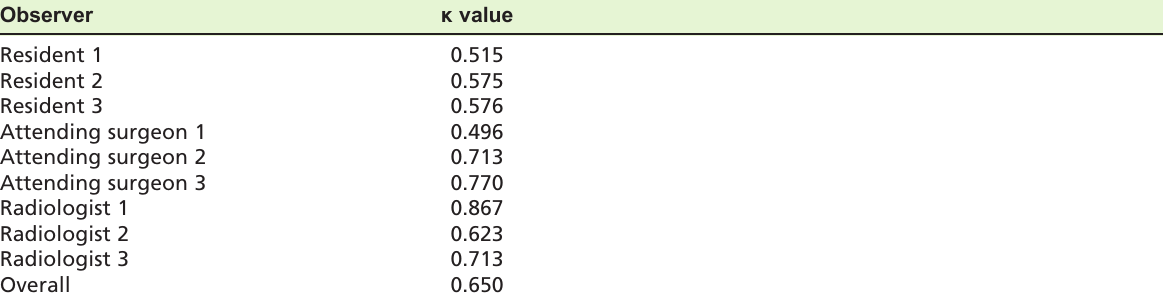
Table III: Intra-observer reliability of all nine observers based on two separate